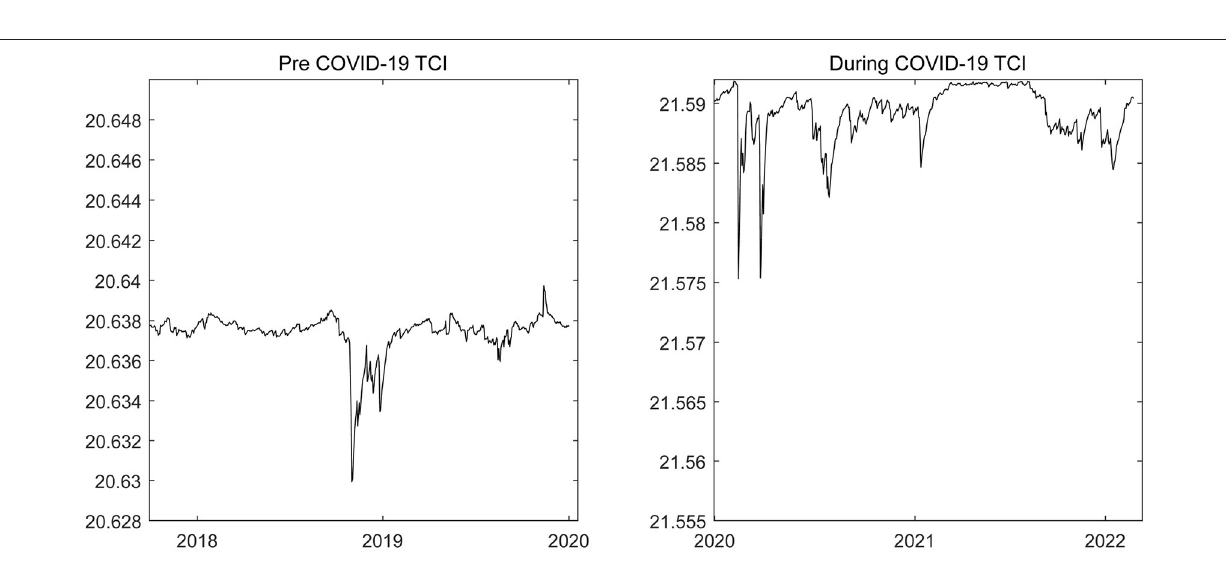
price volatility. This conclusion was also supported by Mensi et al.